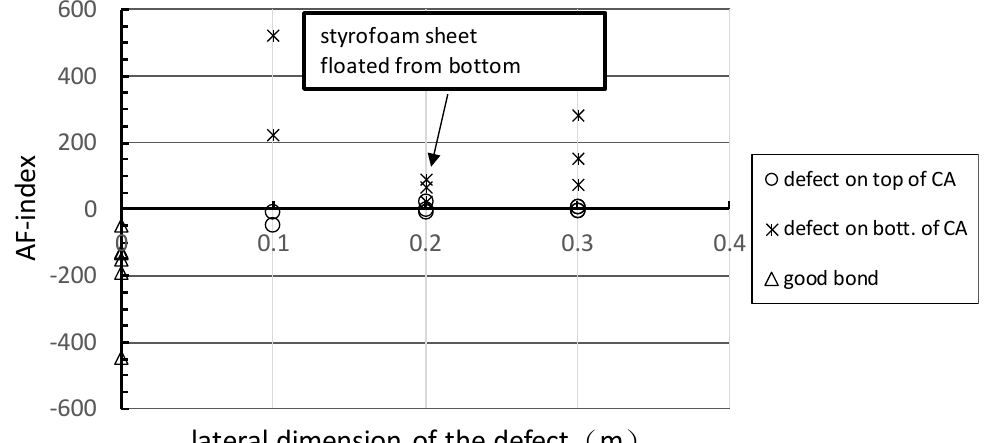
Figure 10. The relationship between the AF index and the lateral dimension of defects for good adhesion, defect on the top and on the bottom of the CA mortar layer.